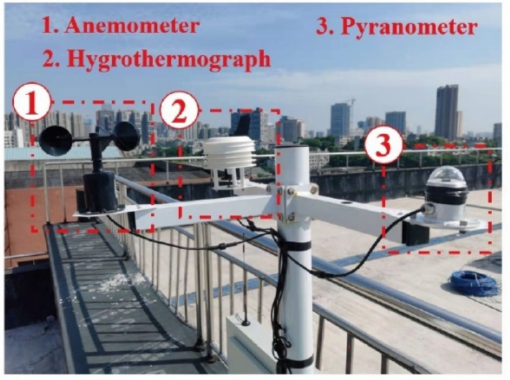
Figure 4. Small weather monitoring